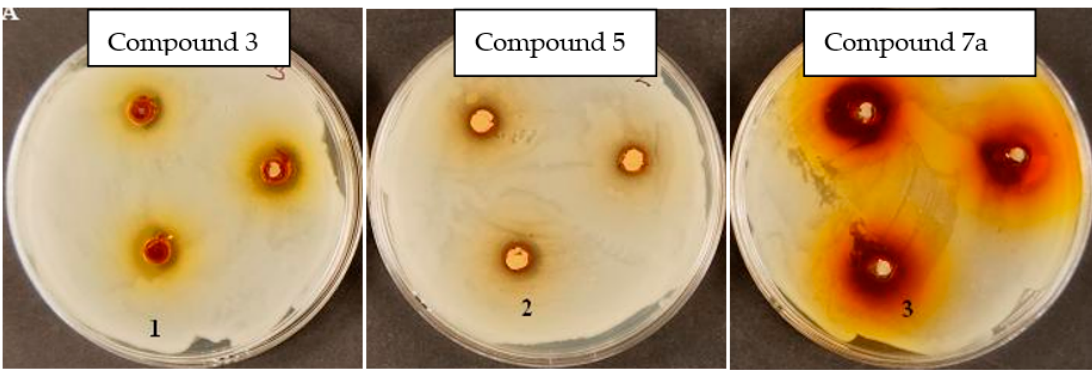
Figure 10. Bacillus subtilus treated with dyes 3, 5, and 7a.